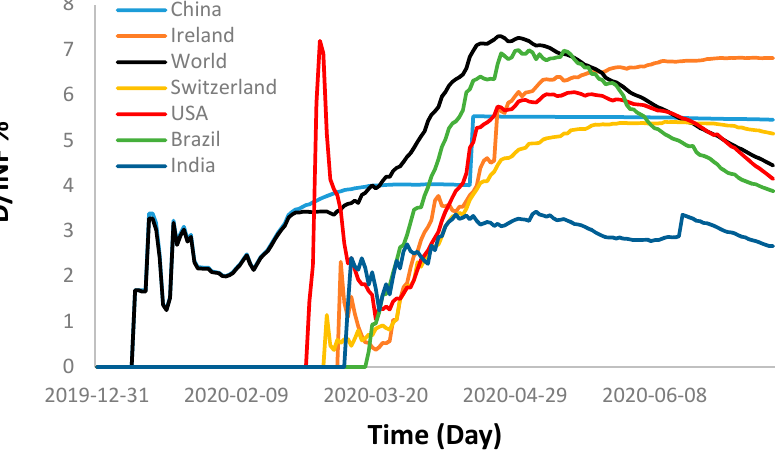
Figure 11. Death percentage rates of some of the selected countries along with the total death cases of the world.